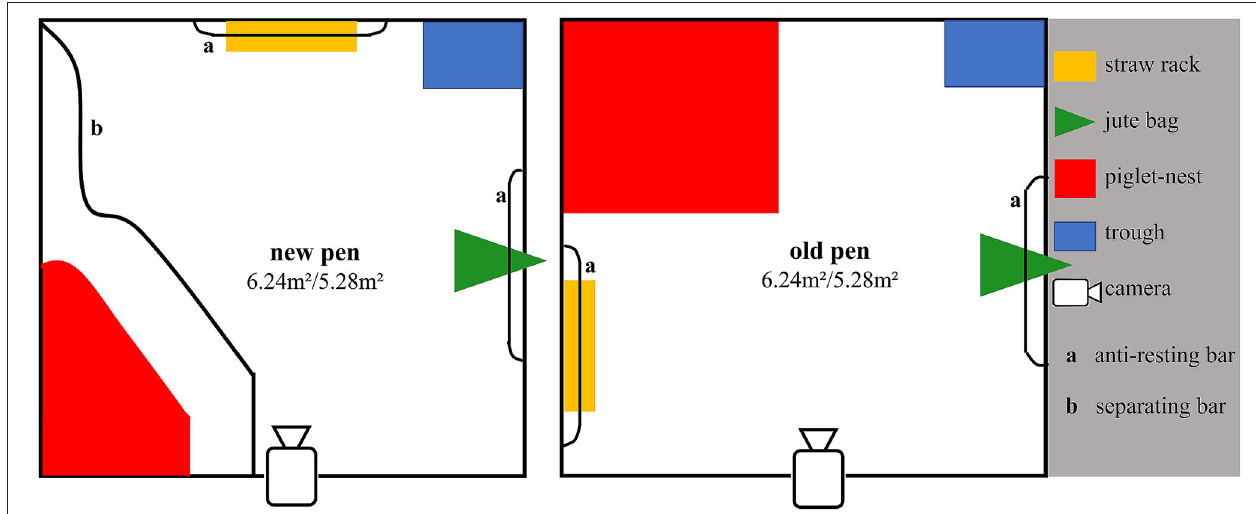
FIGURE 1 | Schematic illustration of the camera installation for a new (left) and an old (right) design of the farrowing pens within a group farrowing compartment. Due to different size of compartments, the pens were 2.6 × 2.4m (big) or 2.4 × 2.2m (small). The white areas within a pen show the areas that are freely available to a sow.